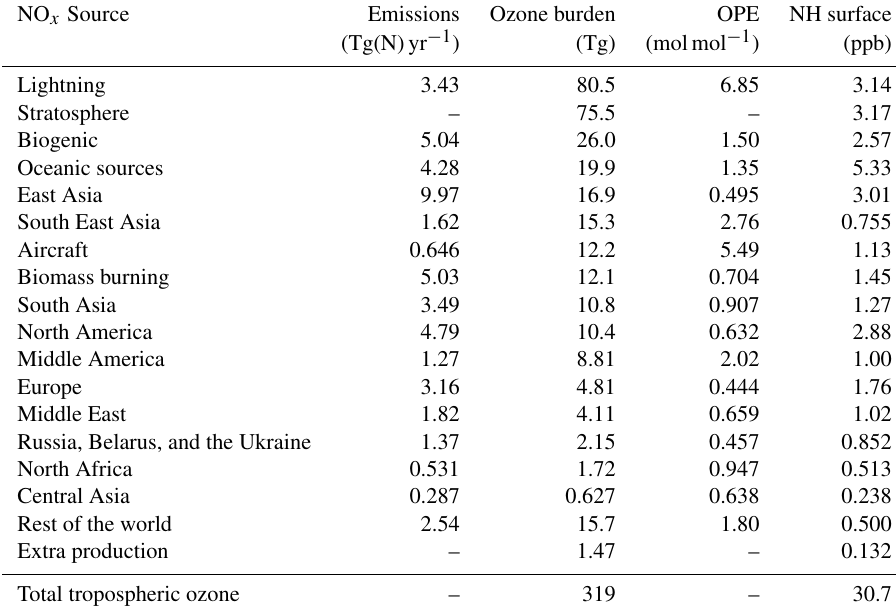
Table 2. The attribution of ozone to tagged sources of NO x . Also shown are the contribution of the stratosphere and the contribution of minor chemical production pathways in the troposphere. Contributions of each tagged source to both the 2010 annual average tropospheric burden and to the annual average Northern Hemisphere (NH) surface mixing ratio are shown. Where applicable, the ozone production efficiency (OPE) of NO x emissions from each tagged source is also